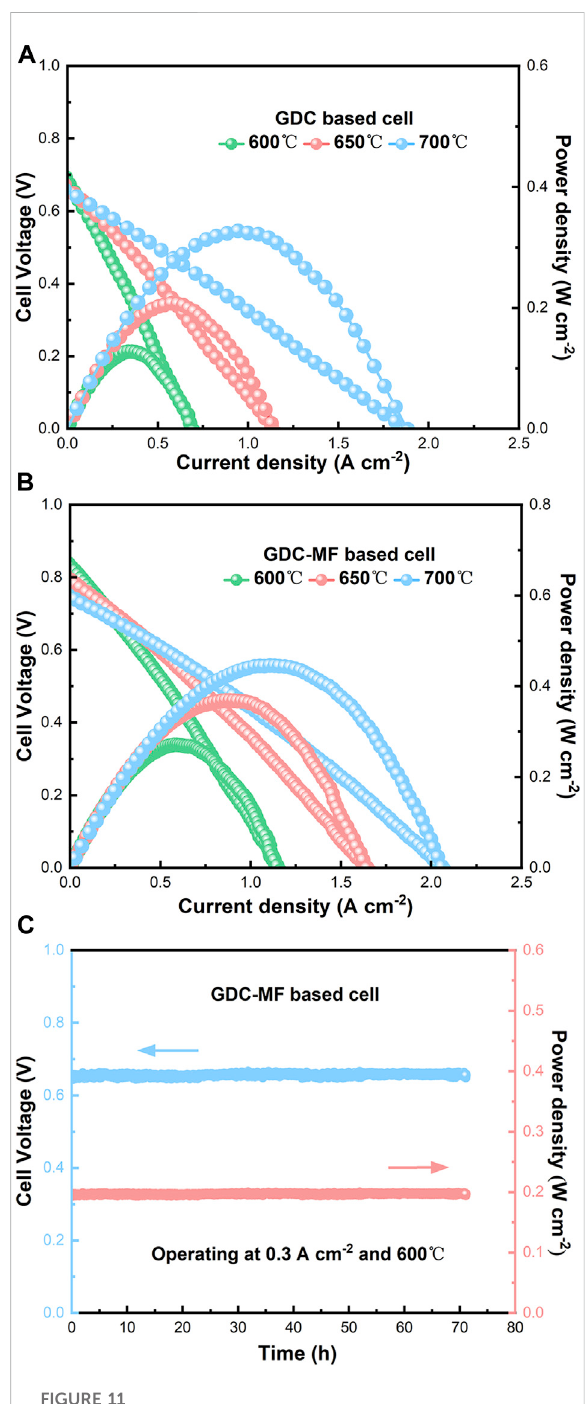
FIGURE 11 Electrochemical performance measured at 600 ° C, 650 ° C, and 700 ° C of (A) the GDC, (B) GDC-MF electrolyte-based SOFC, and (C) long-term stability of Cell-II measured at 600 ° C for 70